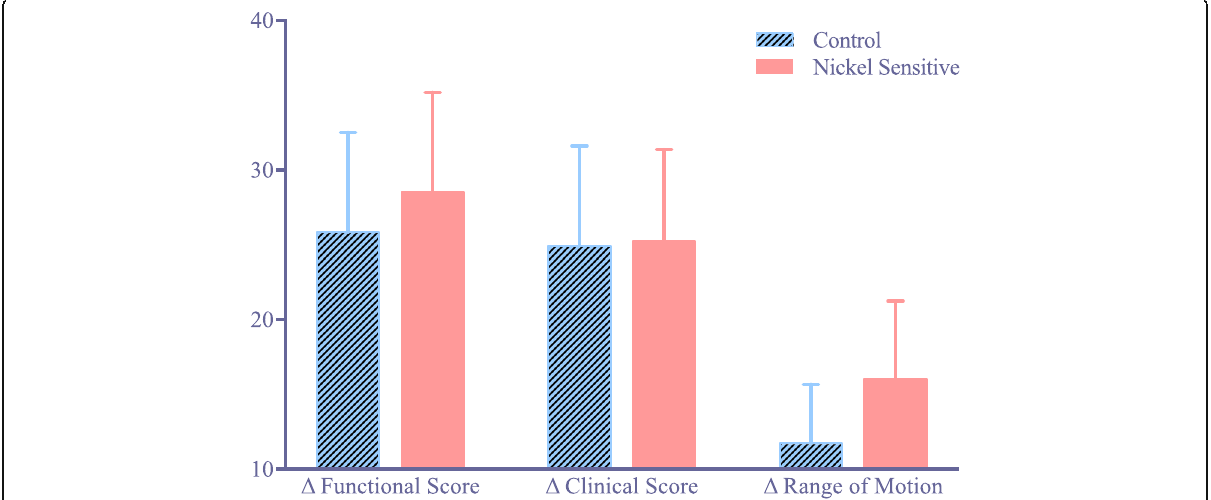
Fig. 4 Average increase in range of motion, clinical, and functional Knee Society scores between control and nickel sensitive patients. Error bars show standard error. No significant difference in improvement of functional score, clinical score, or range of motion was found between the control ( n = 13) and nickel sensitive ( n = 19)